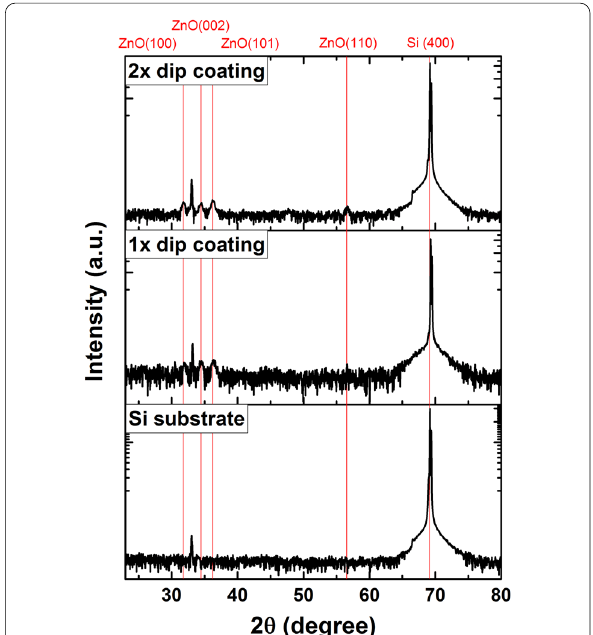
Fig. 3 XRD diffraction pattern of a bare Si substrate and of ZnO NP seed layers deposited on a (100) Si substrate by dip-coating. Each dip-coating is followed by an annealing step at 300 °C for 10 min